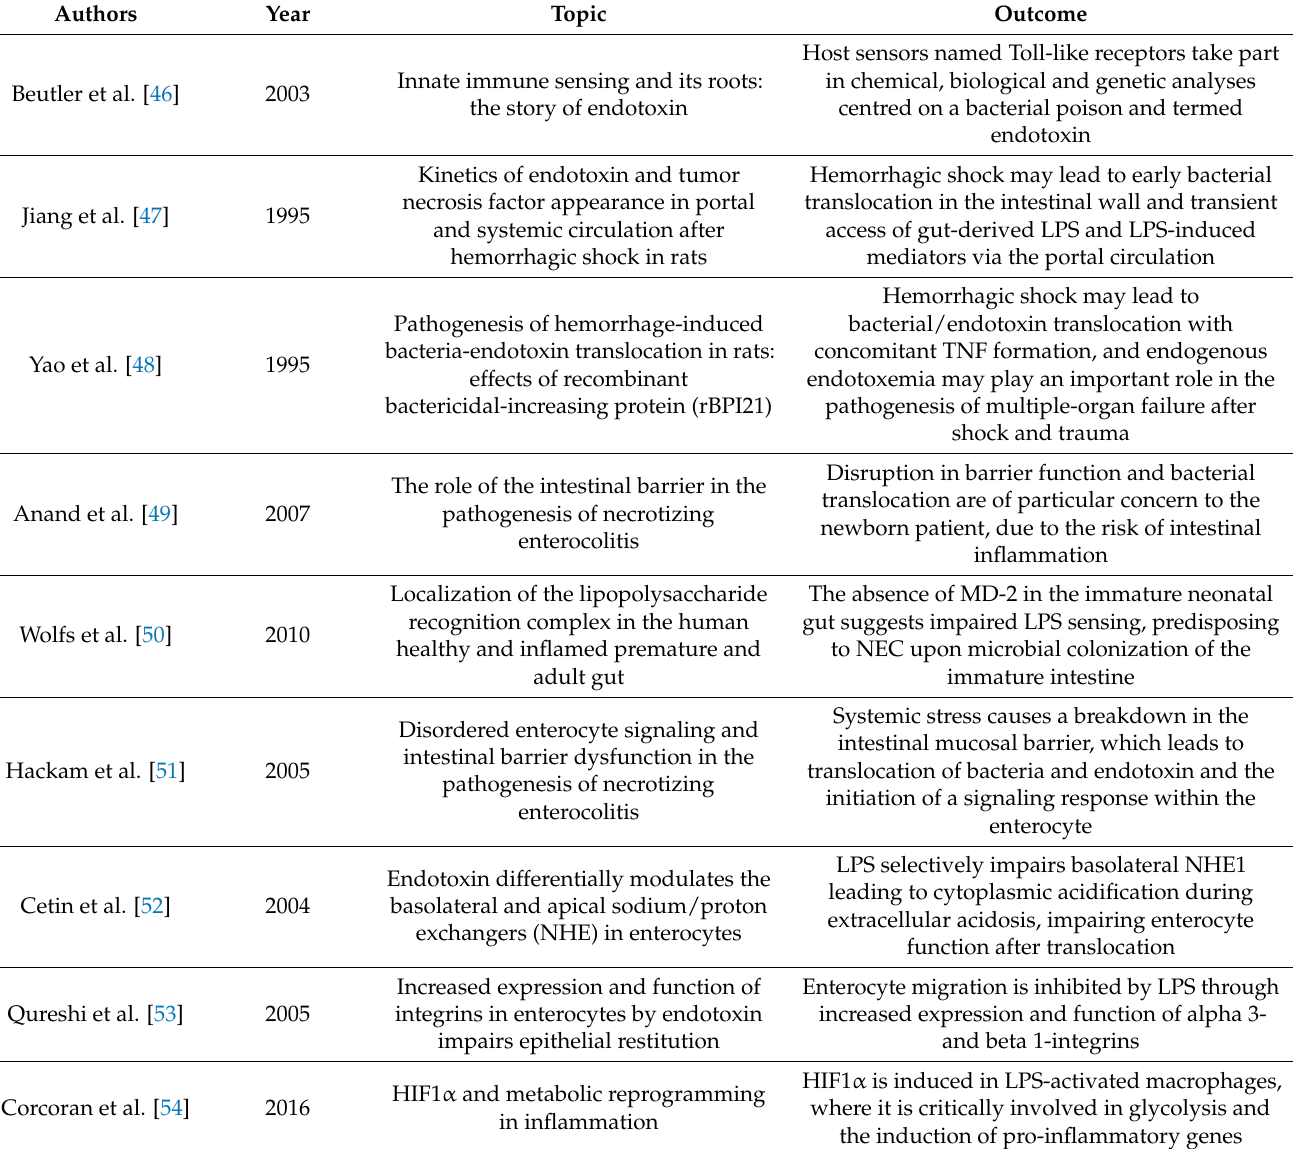
Table 5. Bacterial lipopolysaccharides (LPS/Endotoxins) and their role in the inflammatory pathway of